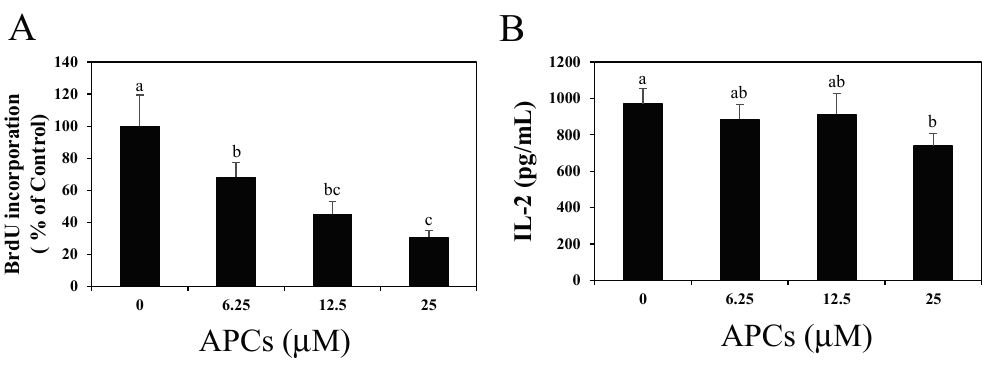
Figure 1. Dose-dependent effects of apple procyanidins (APCs) on antigen-specific cell proliferation ( A ) and interleukin (IL)-2 production ( B ) of activated splenocytes from naïve DO11.10 mice. Pooled splenocytes were stimulated with 7.5 μ M of ovalbumin (OVA) in the presence of APCs (0–25 μ M). ( A ) Splenocyte proliferation was evaluated by measuring the incorporation of BrdU after 72 h of stimulation. The group without APCs treatment (0 μ M of APCs) was indicated as control. The data shown are the means ± SD from three independent experiments; ( B ) IL-2 secretion 48 h after stimulation was measured by ELISA. The data shown are the means ± SD from triplicate cultures. Values not sharing a common letter (a, b, c) differ significantly at p < 0.05 by the Tukey-Kramer multiple comparison test.